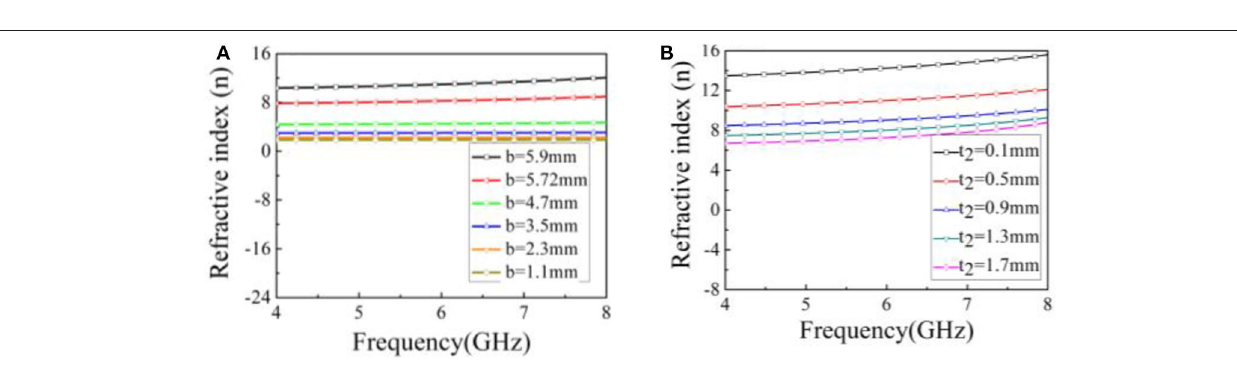
proposed as ground plane or superstrate of antenna [13, 14].